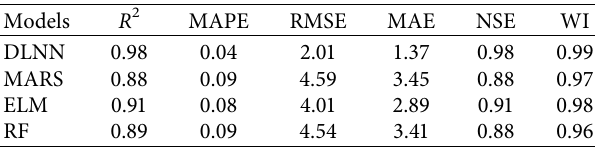
Table 5: Statistical measures for the developed AI model across the training phase for 90-10% data division scenario.